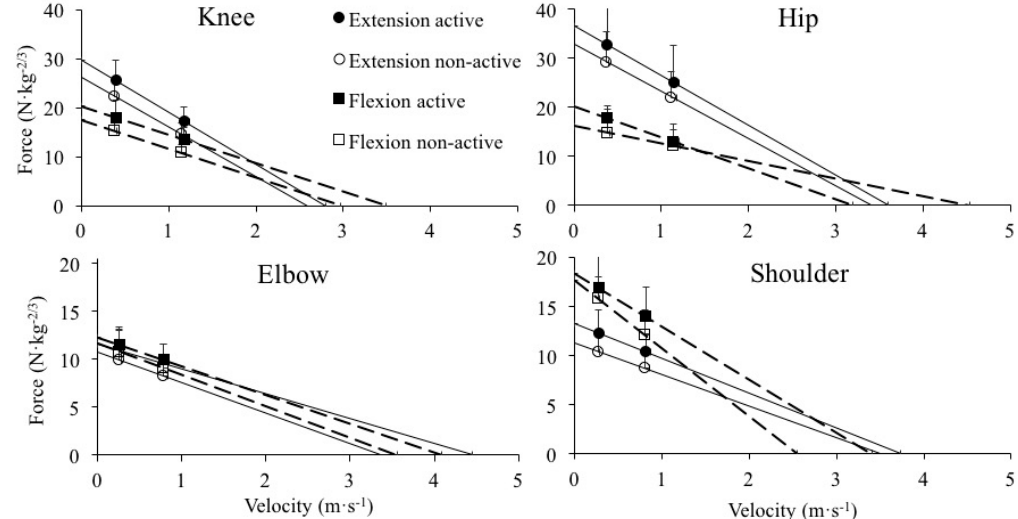
Figure 1. Linear regression models obtained from the force and velocity data averaged across the participants during the knee extension and flexion ( upper-left panel ), elbow extension and flexion ( lower-left panel ), hip extension and flexion ( upper-right panel ) and shoulder extension and flexion ( lower-right panel ) tasks. Straight and dashed lines represent extensor and flexor muscles, respectively. The error bars represent the standard deviation obtained by flexors (squares) and extensors (circles) groups.